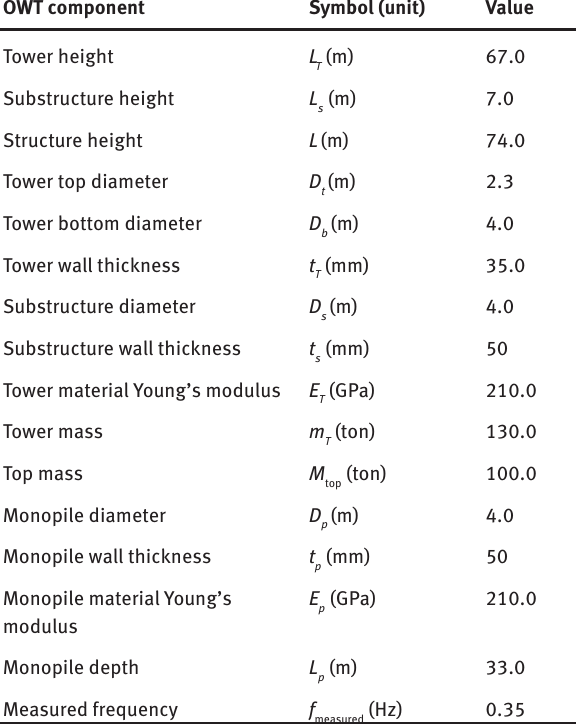
Table 4: North Hoyle OWT’s structural